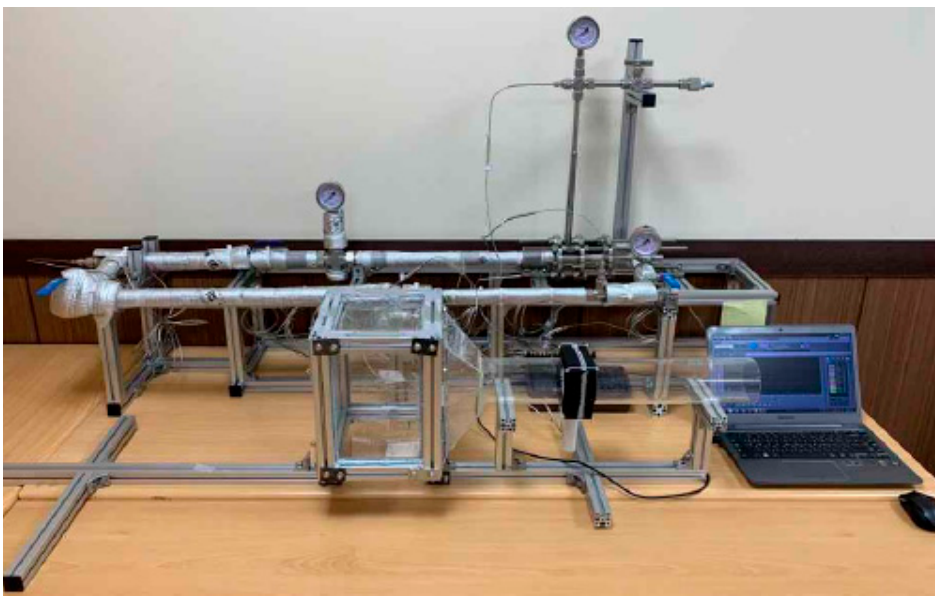
Figure 10. Photograph of the direct experimental device with air conditioning filter.